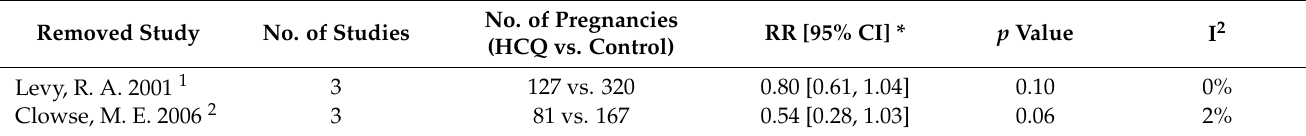
Table 2. Sensitivity analyses for the risk of high lupus